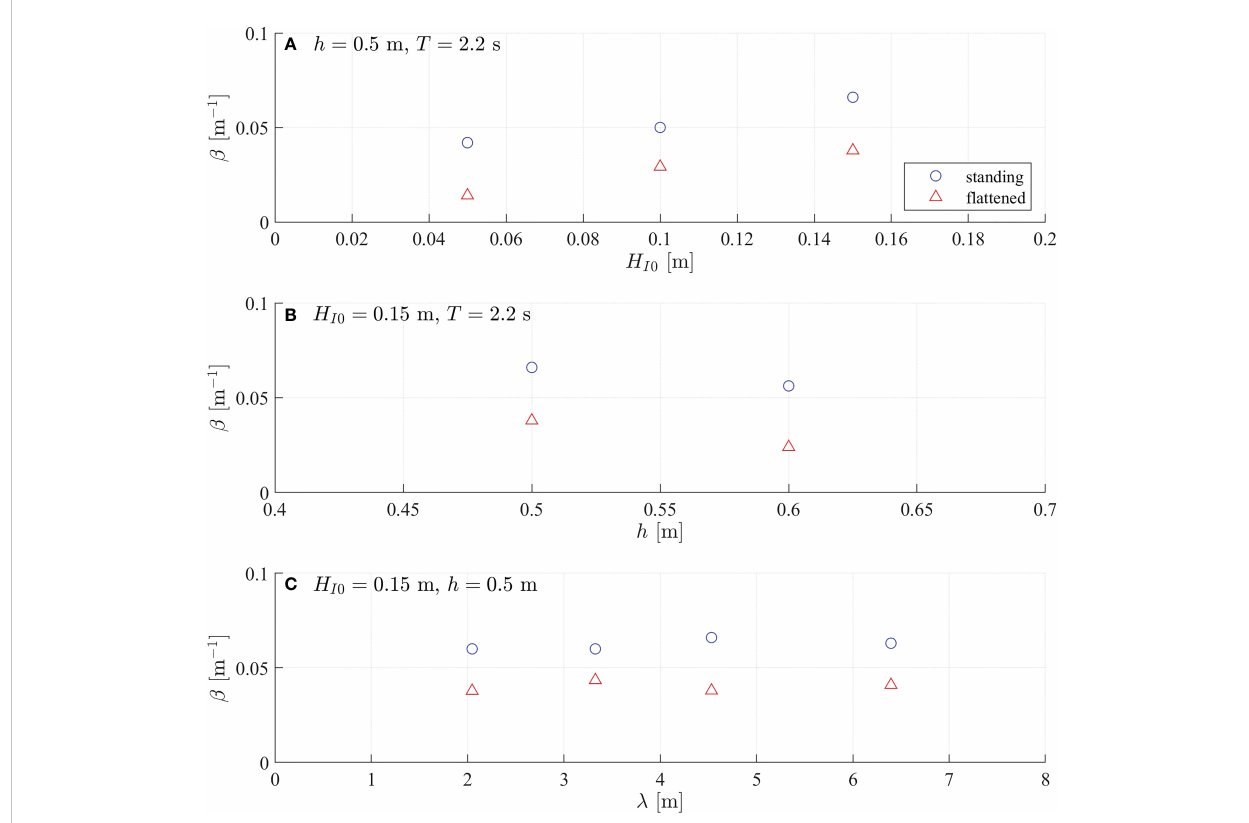
FIGURE 3 Measured wave damping coef fi cient ( b ,m – 1 ) as a function of (A) incident wave height ( H I 0 ,m), (B) water depth ( h ,m), and (C) wavelength ( l ,m). The results for standing and fl attened vegetation are denoted by blue circles and blue triangles, respectively.